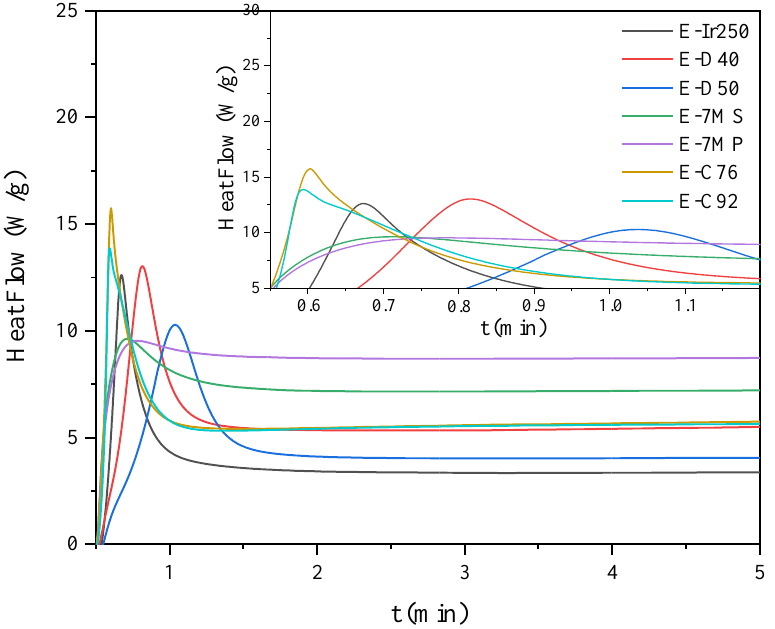
Figure 8. Photo-DSC exotherms for the photopolymerization of epoxy resin formulations with cationic photoinitiators.